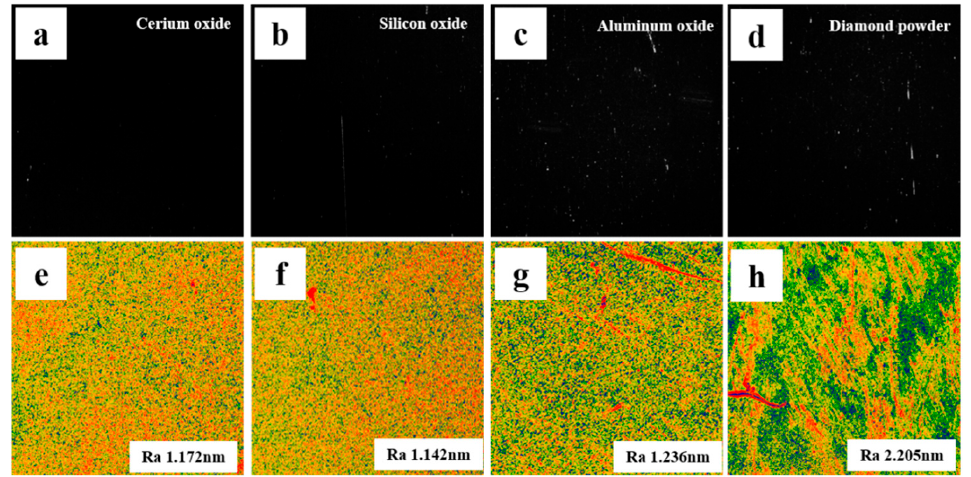
Figure 13. Typical defect and roughness distribution diagram of the component surface under the action of abrasive with different hardness ( a ) CeO 2 and ( e ) Ra 1.172 nm; ( b ) SiO 2 and ( f ) Ra 1.142 nm; ( c ) Al 2 O 3 and ( g ) Ra 1.236 nm; ( d ) C and ( h ) Ra 2.205 nm.